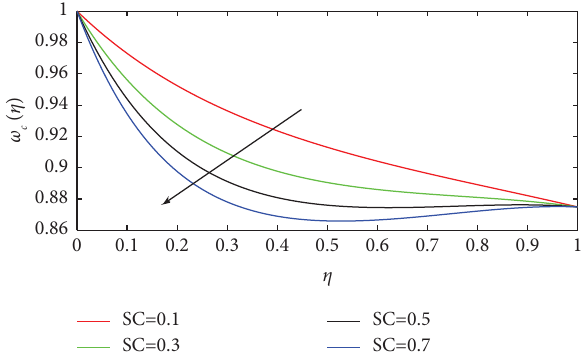
Figure 16: Concentration profles for the diferent values of Sc.